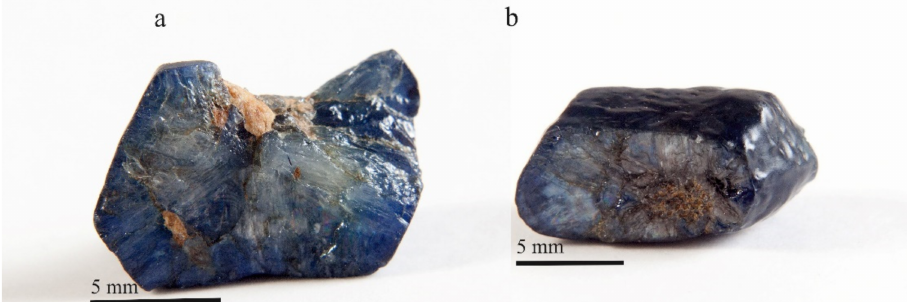
Figure 6. Trapiche sapphires. ( a ) Cleavage plate of a large prismatic crystal with chipped and induction surfaces of co-growth with other crystals, the grains are melted and corroded, contains inclusions of altered feldspar; ( b ) a flattened prismatic crystal, the grains are melted and corroded. The sapphires are translucent to semi-translucent, 3–7 mm, sometimes 15 mm or more